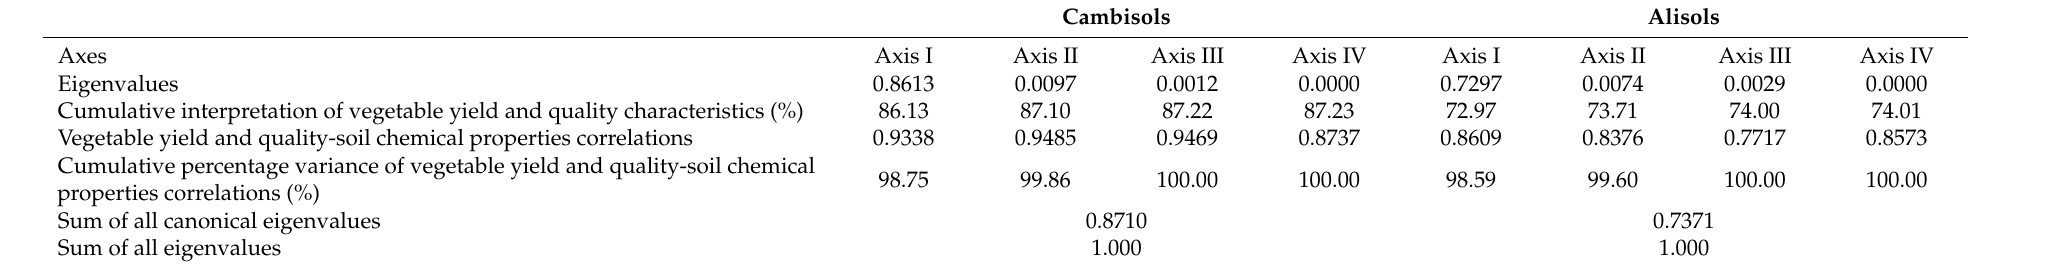
Table 5. Summary of the RDA results for yield and quality of water spinach in relation to soil chemical